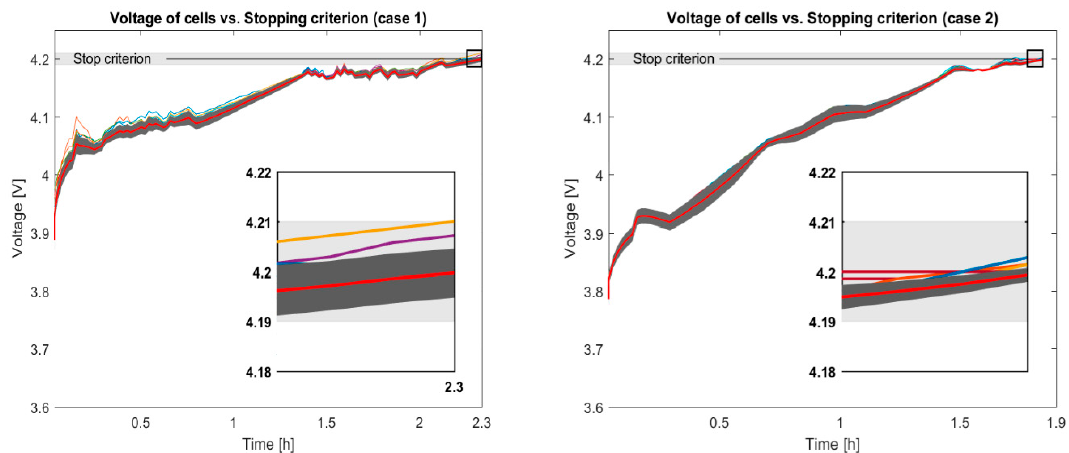
Figure 20. Voltage profile per cell vs. stopping criterion. The red line represents mean voltage, the gray